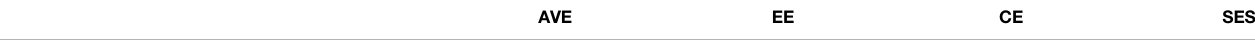
TABLE 2 | Convergent and discriminant validity of the 14-item model of C-ETS. AVE EE CE SES Emotional engagement (EE) 0.728 − Cognitive engagement (CE) (3 items) 0.564 0.490 − 0.589